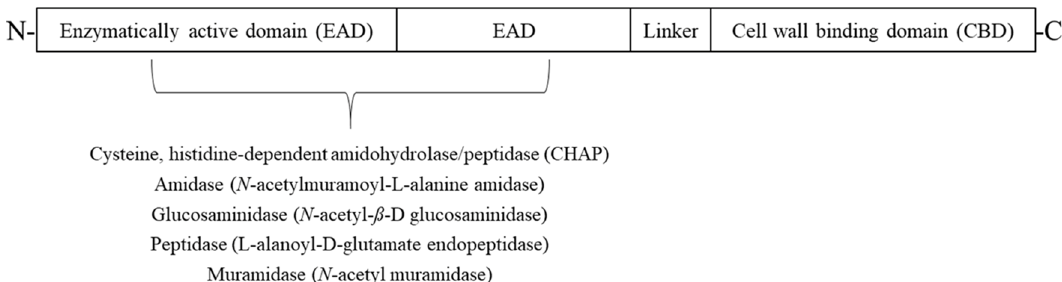
Figure 1. Schematic representation of the modular structure of phage-encoded peptidoglycan hydrolases. Most endolysins contain one or two enzymatically active domain (EAD) in N-terminal those cleave one of the bonds in the bacterial peptidoglycan, and one cell wall binding domain (CBD) involved in host bacterial recognition in C-terminal region. EAD and CBD are connected by a short linker.